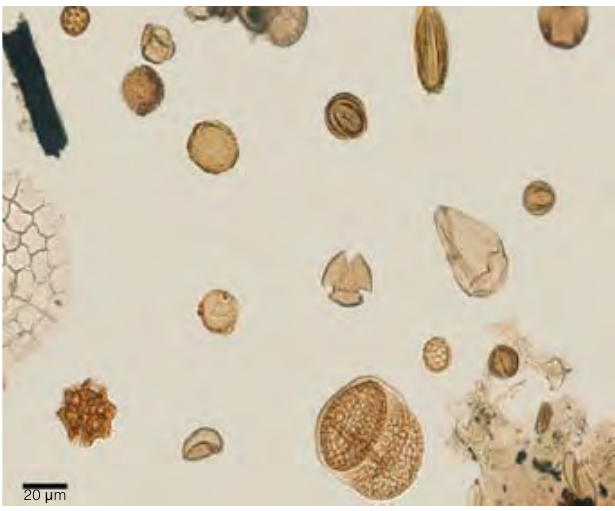
20 μ Figure 4. Typical glacial pollen spectrum from the new core (Sample is from a core depth of 10.0 m, corresponding to Marine Isotope Stage 3).